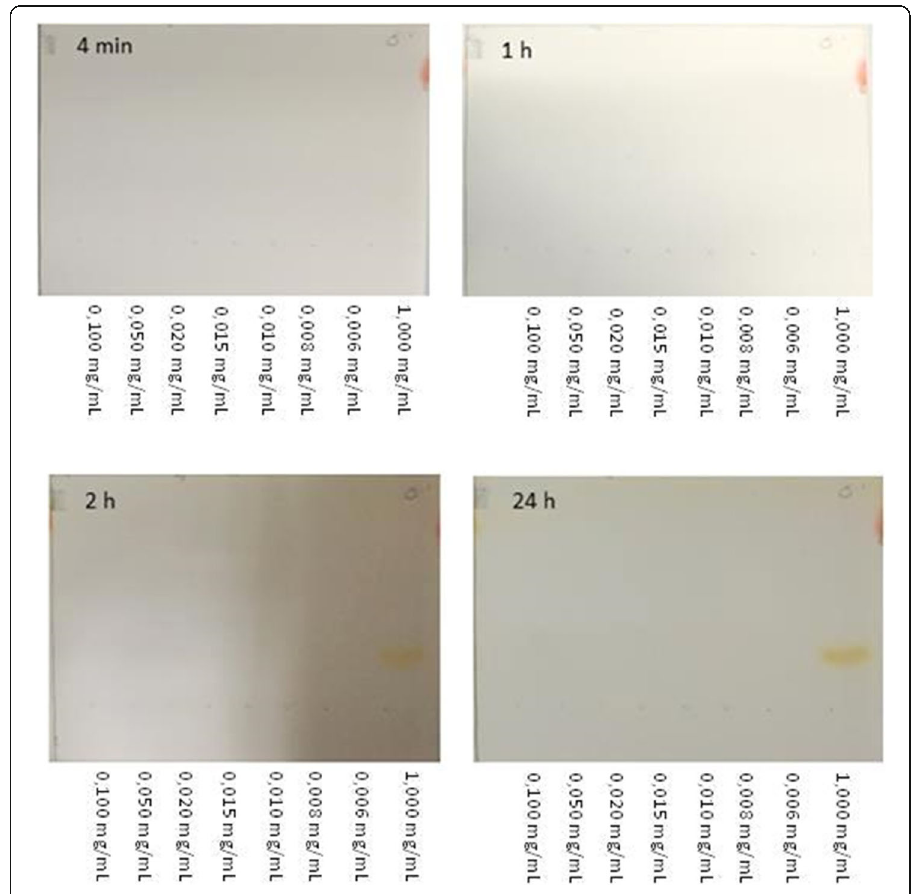
HEPES analysis in different 68 Ga-radiopharmaceuticals The HEPES concentrations in the final formulations of [ 68 Ga]Ga-DOTATOC, [ 68 Ga]Ga-PSMA-11 and [ 68 Ga]Ga-NODAGA-Exendin that were analyzed by the HPLC method are stated in Table 3.